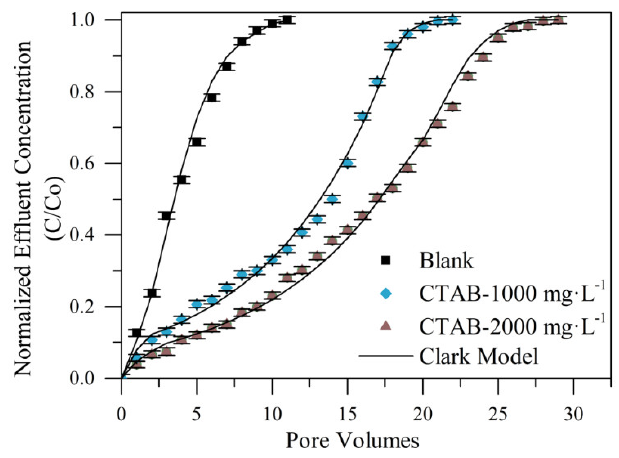
Figure 9. Breakthrough curves for two different concentrations of the CTAB treatment of system I in Ottawa 20/40 sand packed bed assessed with kaolinite fines at 0.2% in mass fraction solution and 25